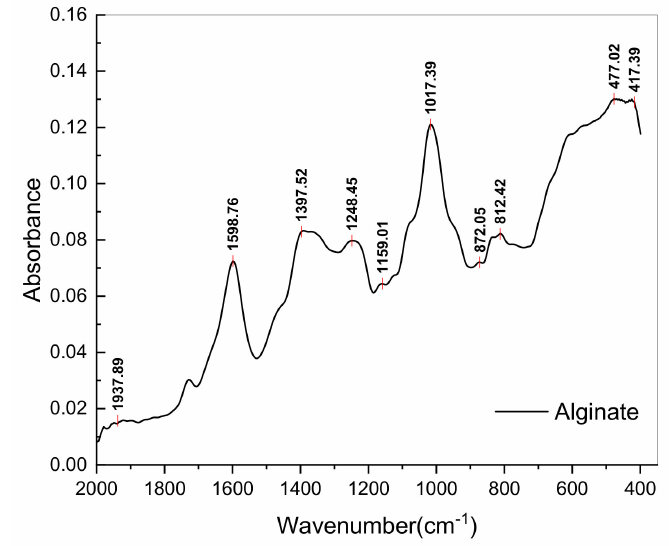
Figure 4. FTIR spectrum of alginate extract separated from Fucus spiralis biomass.